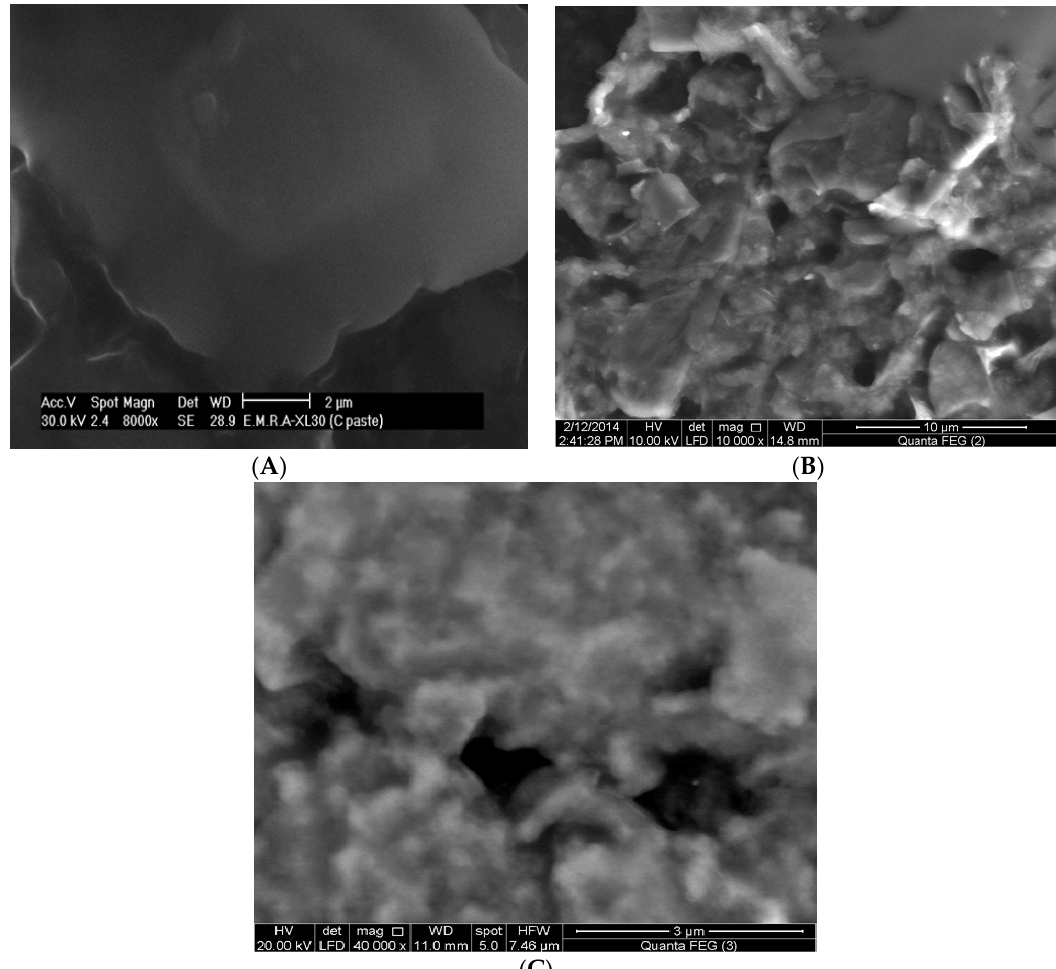
Figure 1. SEM micrographs of: ( A ) CPE; ( B ) ILCCPE; and ( C ) ILCCPE…SDS.